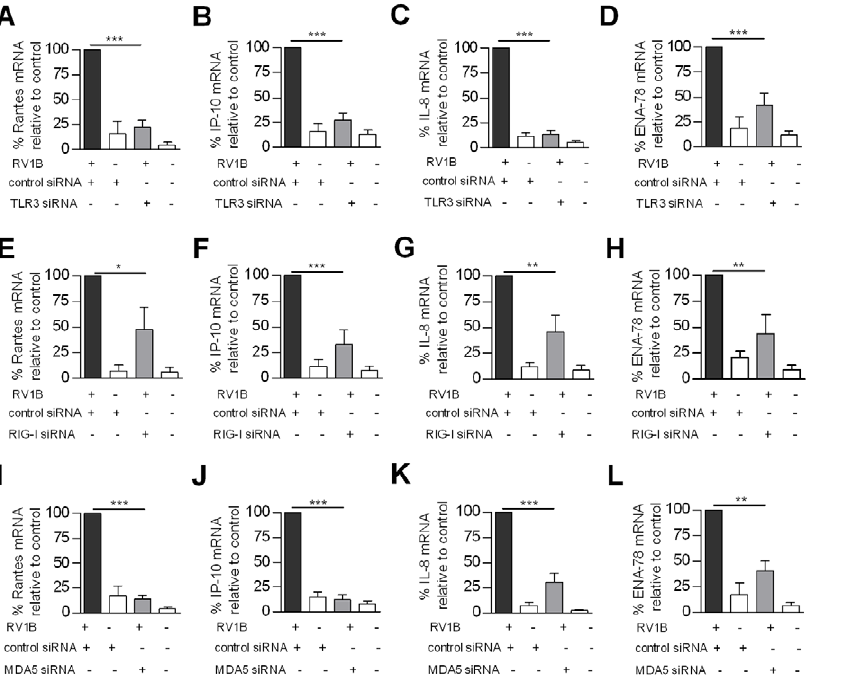
Figure 5. Role of TLR3, RIG-I and MDA5 in RV1B induced pro-inflammatory cytokine gene expression in HBECs. HBECs were transfected with control siRNA or siRNA specific for TLR3 (A–D), RIG-I (E–H), MDA5 (I–L), and infected with RV1B. Rantes (A,E,I), IP-10 (B,F,J), IL-8 (C,G,K), and ENA-78 (D,H,L) mRNA were measured 24 h post infection * p , 0.05, ** p , 0.01, *** p , 0.001 versus control siRNA. * p , 0.05, ** p , 0.01, *** p , 0.001 versus control siRNA or as indicated. mRNA data was generated from 6 independent experiments utilizing 3 independent HBEC donors, 2